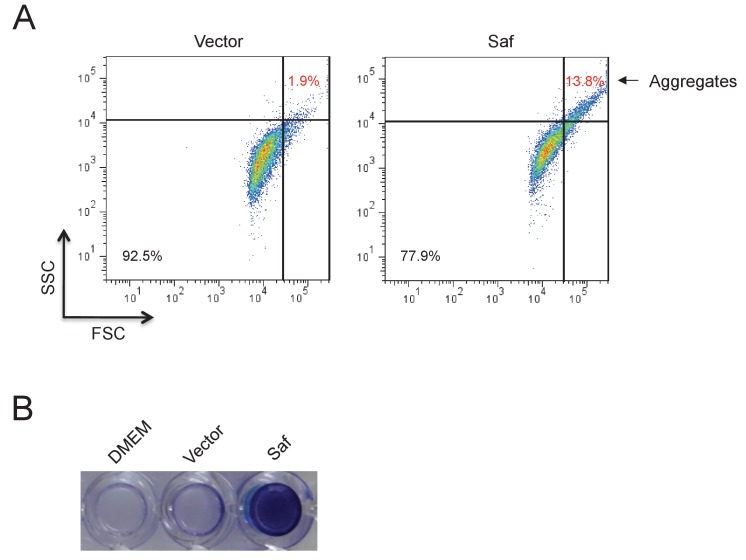
Saf-driven bacterial aggregation.(A) Aggregation analysis by flow cytometry. The E.coli DH5α cells harboring Saf pili expression plasmid were induced in DMEM medium. The cell aggregations were registered and quantified by high values of FSC and SSC signals. The percentages of bacterial aggregation in Saf- or control-cells were highlighted with red color and arrow. (B) The Saf-driven biofilm formation in E.coli. The E.coli DH5α cells with the expression of Saf pili showed remarkable biofilm formation after incubation in DMEM medium. As controls, DMEM medium alone and E.coli DH5α with pASK-IBA4 empty vector displayed little biofilm activity.